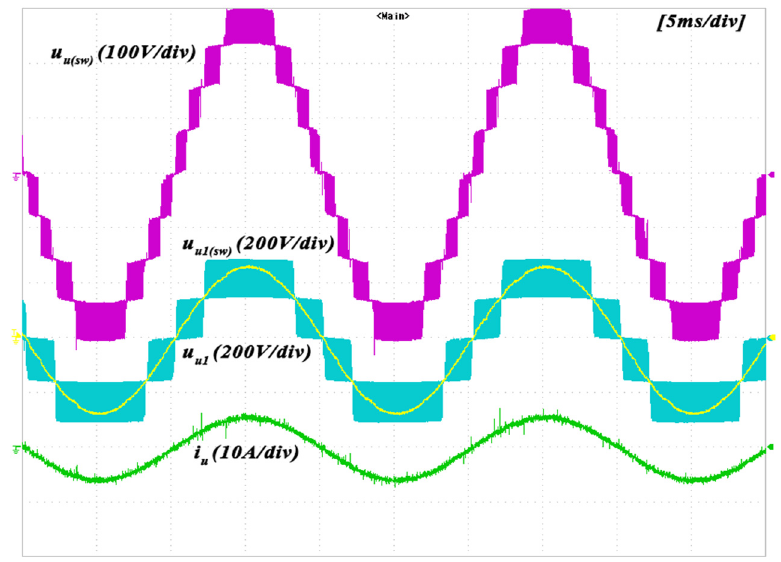
Figure 19. 3 Φ 5L E-Type MMI waveforms, from top to bottom: phase-to-neutral switching voltage u u(sw) , cell-to-neutral switching voltage u u1(sw) , output voltage u u and phase current i u .